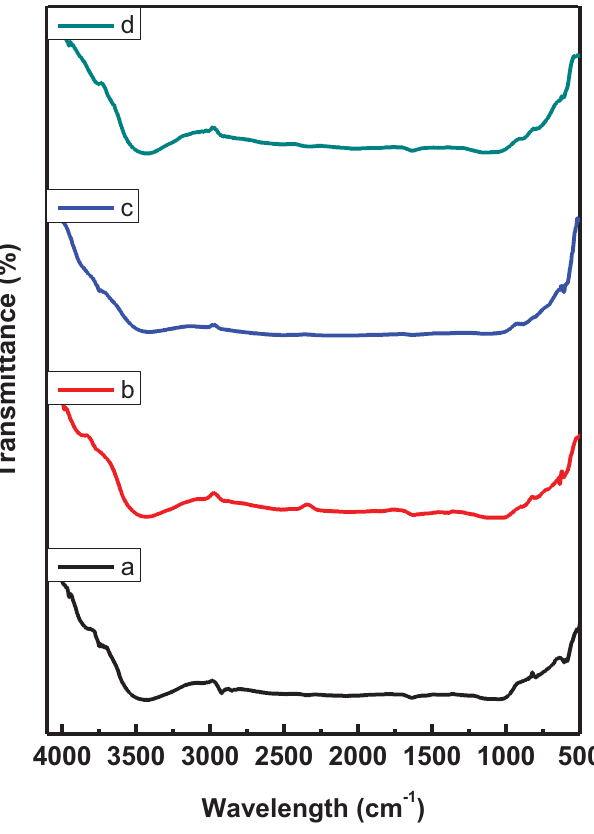
Fig. 5. FTIR spectra of activated carbon from jute fi bers. (a) JUTE-700-1h, (b) JUTE-700-1:1, (c) JUTE-700-1:3 and (d) JUTE-700-1:3.